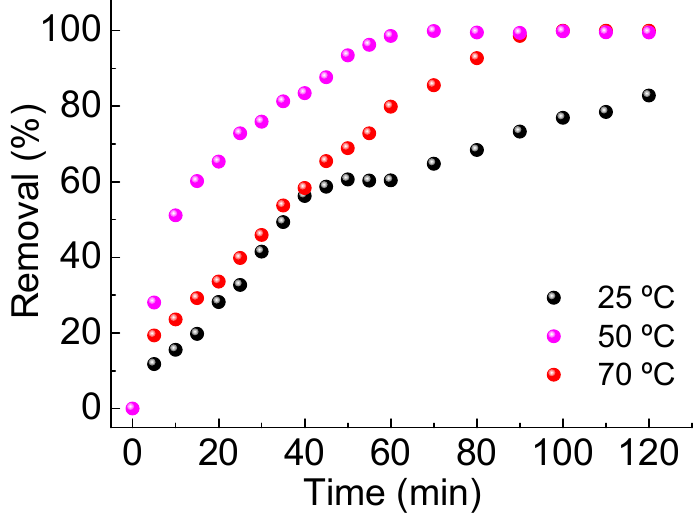
Figure 7. Influence of temperature on the electrofenton process (RVC/A). Applied current 50 mA.